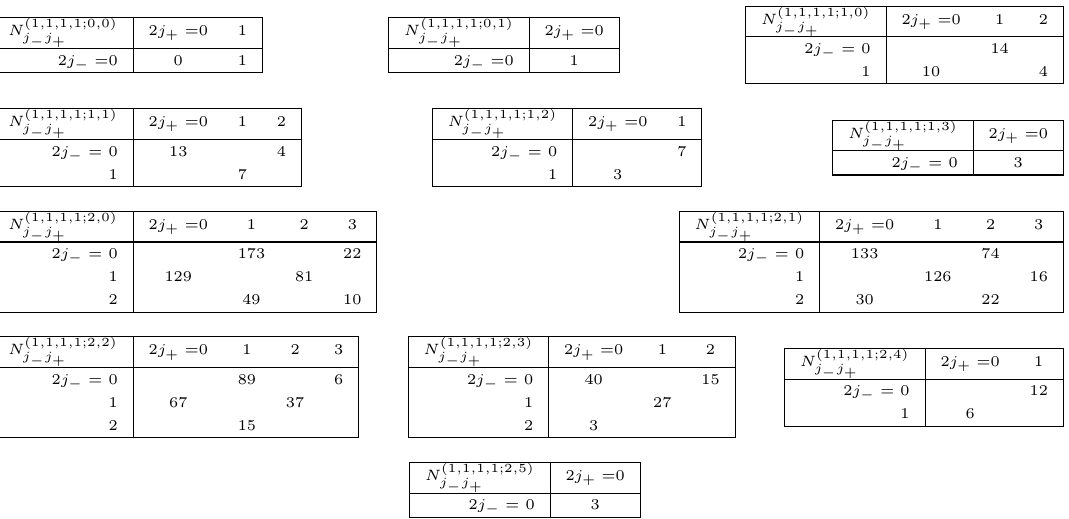
Table 19 . Refined BPS invariants of the massive D 4 chain at base degrees β = (1 , 1 , 1 , 1) and fiber degree e ≤